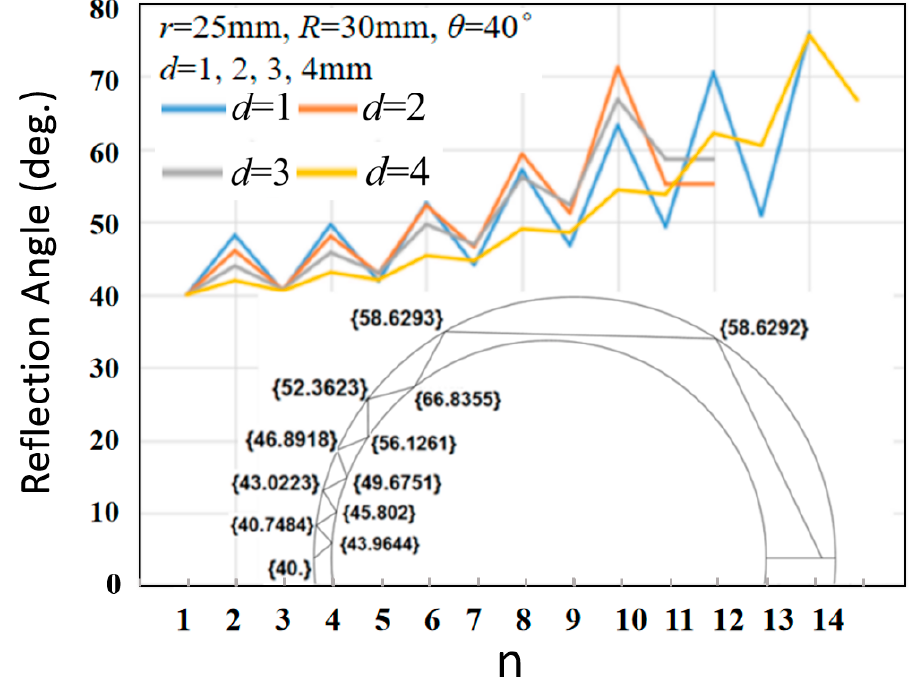
Figure 6. Reflection number dependence of the reflection angle obtained by software programming simulation for light incident on the nonconcentric cross-section waveguide. Here, θ 1 , θ 2 , θ 3 , and θ 4 are the corresponding changes in angle for d = 1, 2, 3, and 4, respectively. n is the number of reflections that occur in the nonconcentric waveguide. The bottom inset shows the angle, in degrees, of each reflection during light propagation in the waveguide, with r = 25, R = 30, d = 3, and θ = 40°.